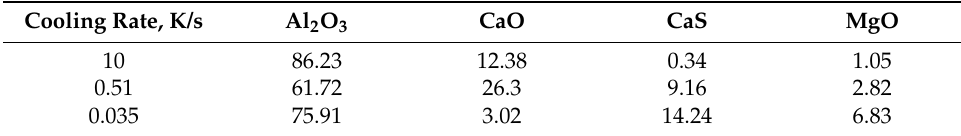
Table 2. Average composition of the inclusions formed at various cooling rates in X80 pipeline steel